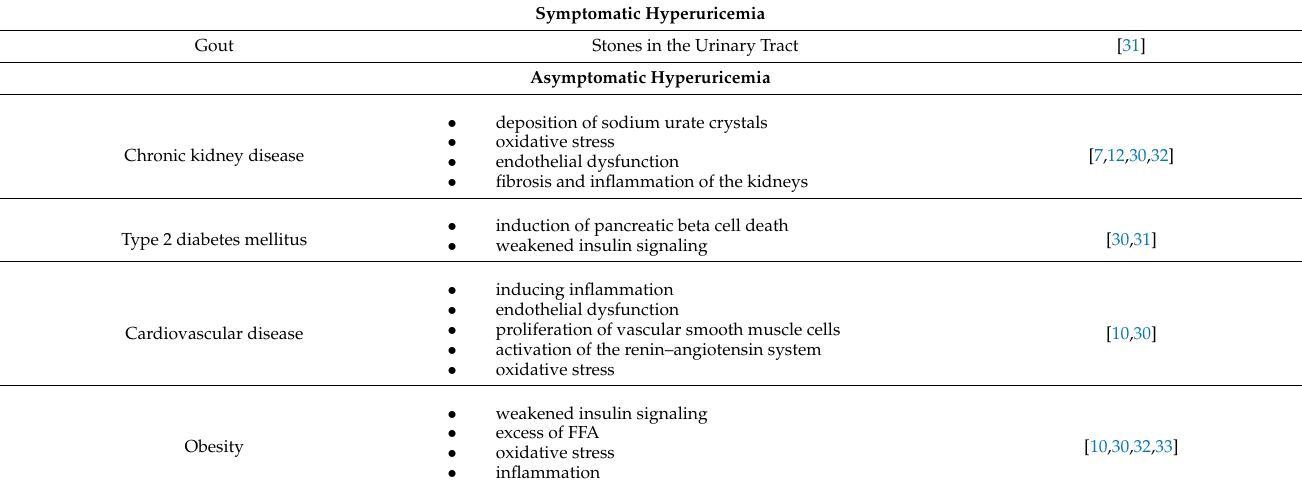
Table 1. Diseases associated with symptomatic and asymptomatic hyperuricemia and their mecha- nism of